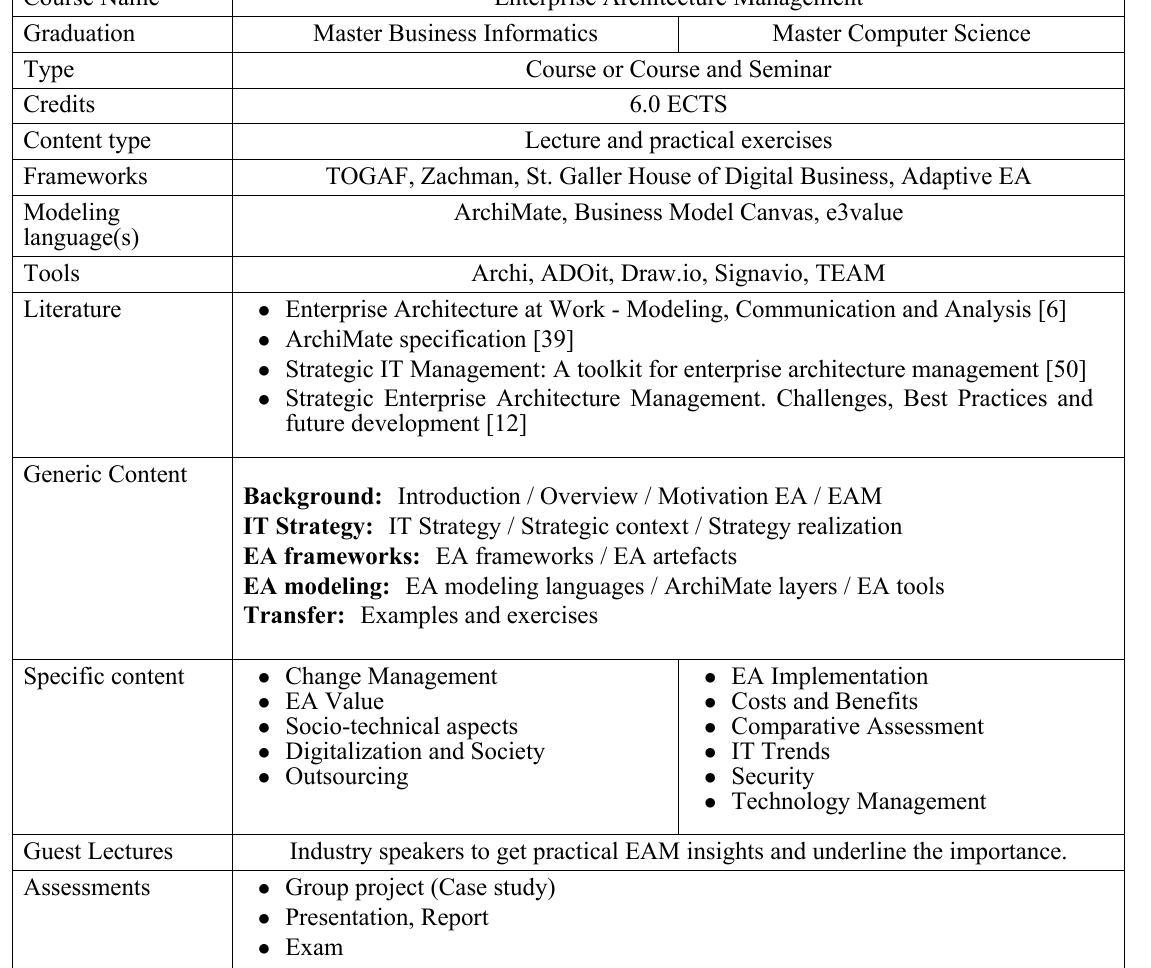
Table 11. A prototypical EAM course with specifics for BI and CS